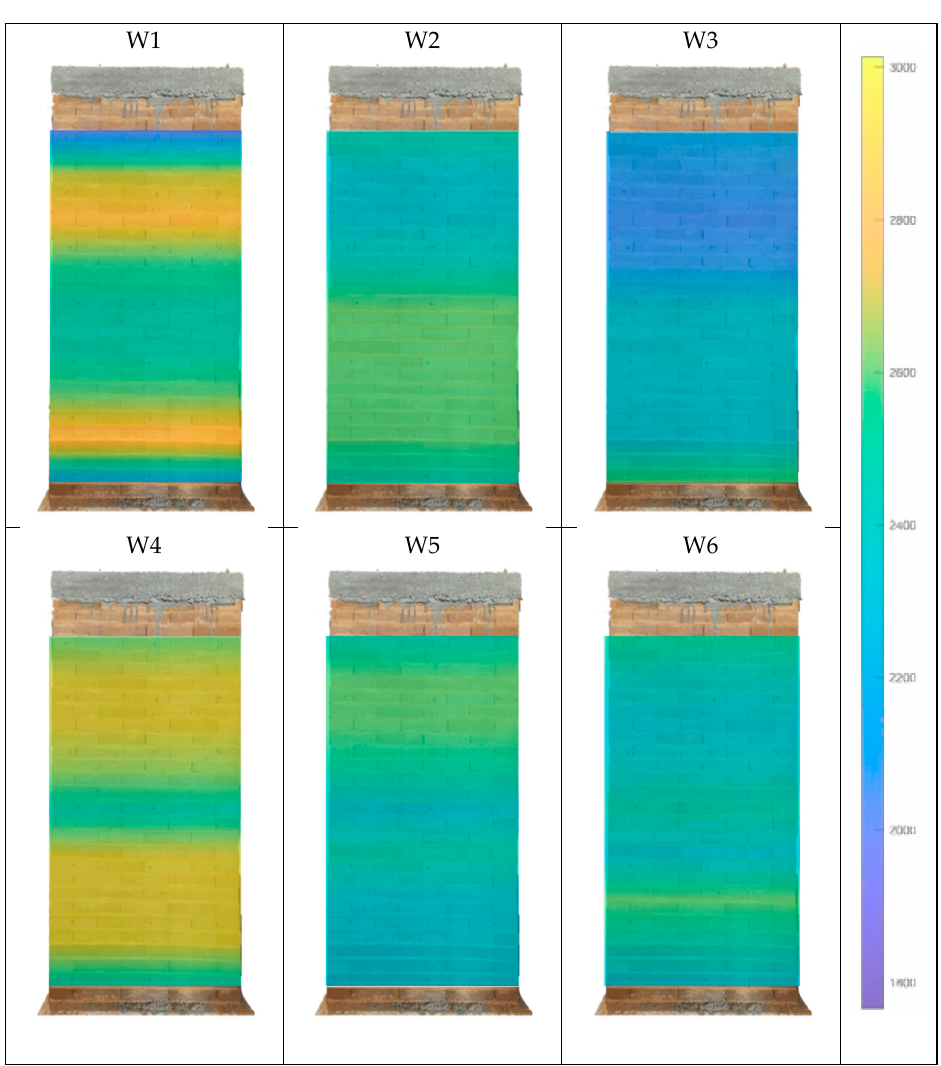
Figure 4. Surface of the direct tests’ velocity data (m/s).